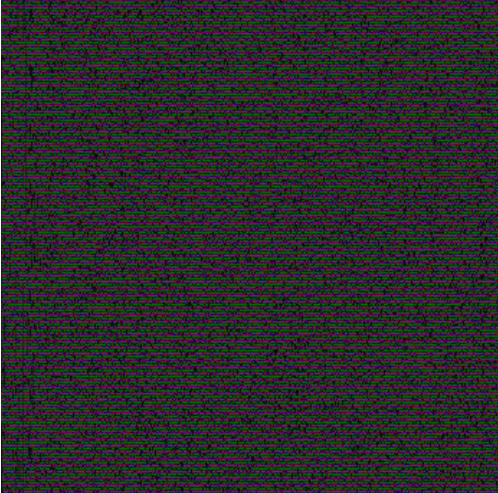
Figure 3. Result for file data1.txt with variant 2 (UTF-8